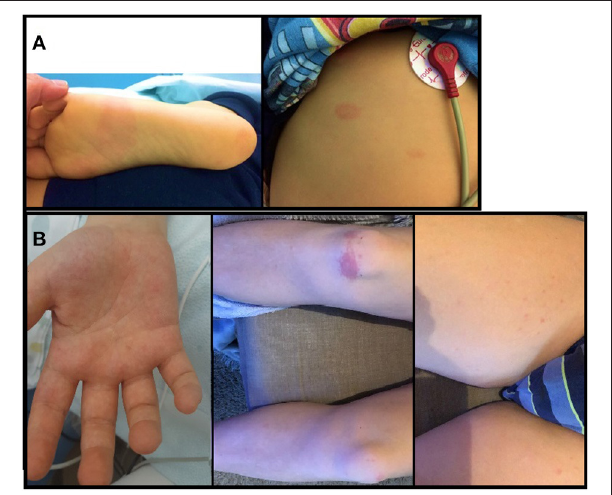
FIGURE 1 | (A) non-itchy macular erythematous rash on the soles of the feet and trunk of the first patient; (B) non-itchy erythematosus rash on palms of the hands, on soles of the feet, on trunk and limbs of the second